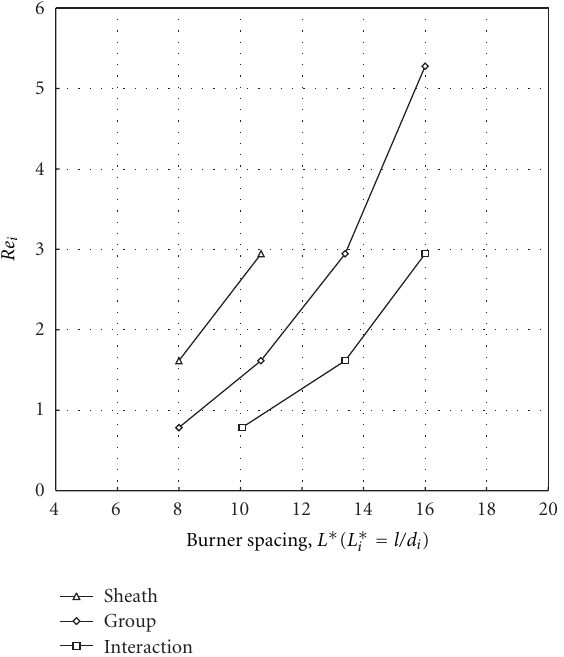
Figure 17: Interburner spacing required for flame interaction and group flame formation as a function of injection velocity for 100% CH 4 fuel.